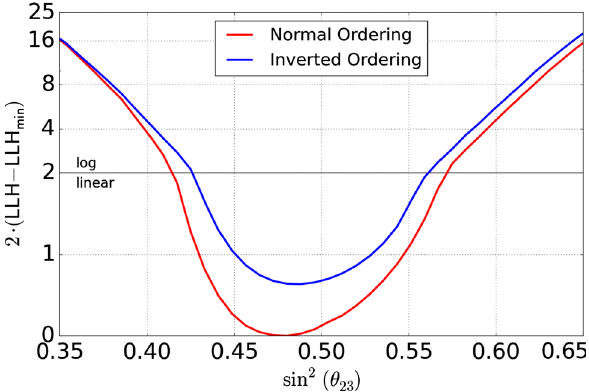
Fig. 11 The negative log-likelihood (LLH) as a function of sin 2 (θ 23 ) for Analysis A , relative to the global minimum LLH min . The preference for NO over IO is visible over all the range of sin 2 (θ 23 ) with the best-fit for both orderings being in the lower octant (sin 2 (θ 23 ) < 0 .